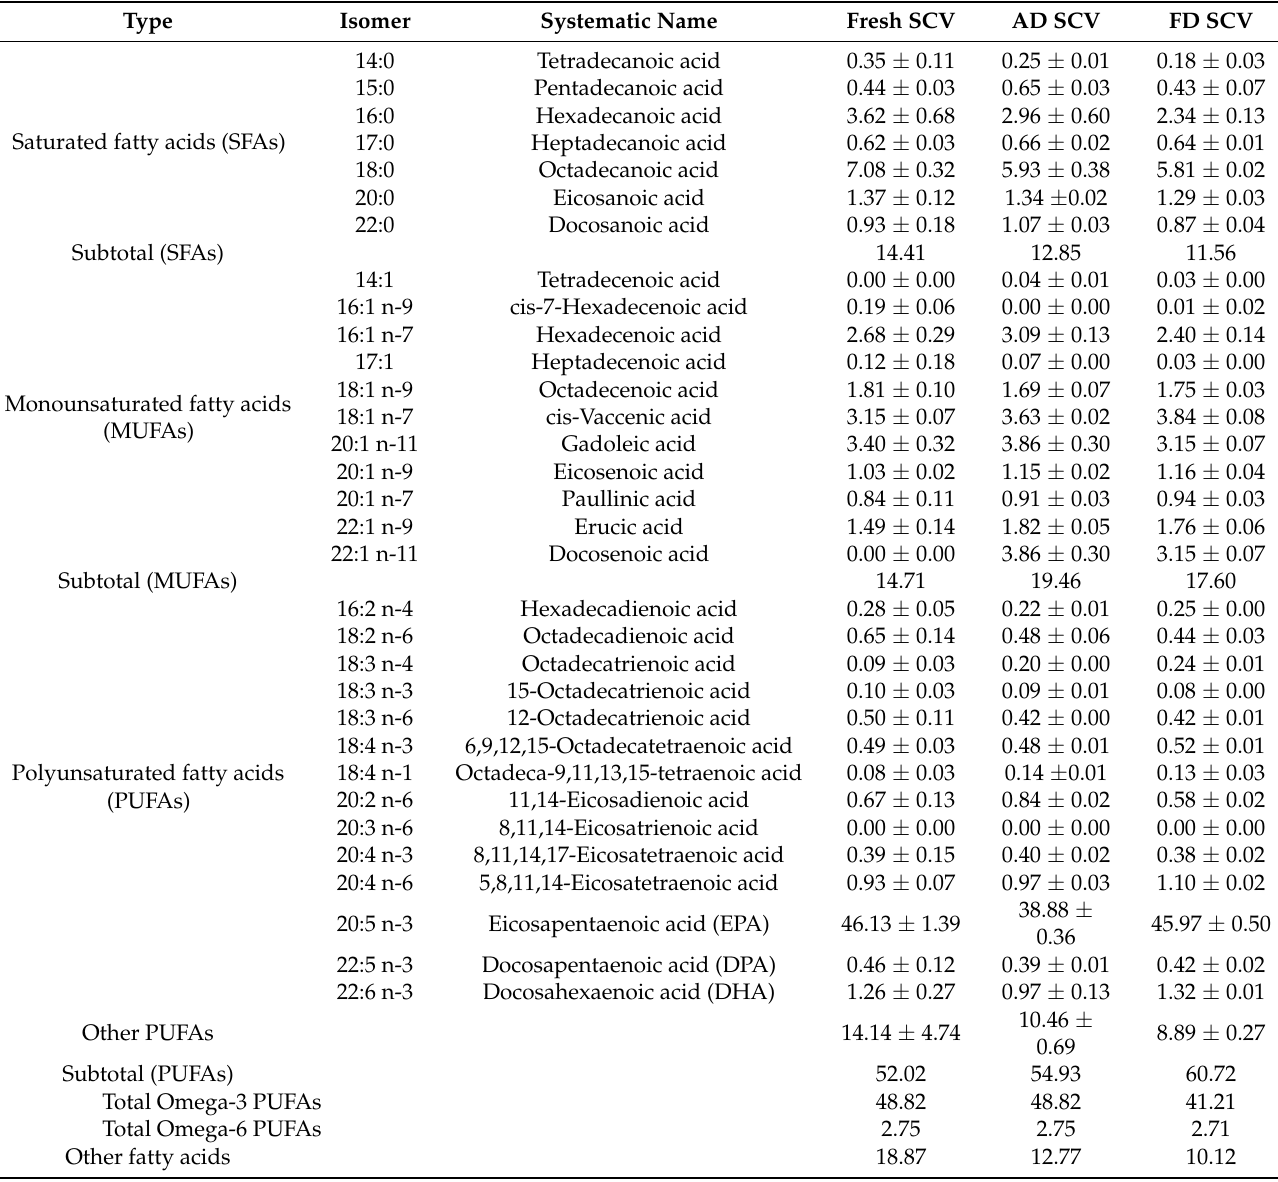
Table 5. Phospholipid fatty acid composition of fresh, air-dried (AD SCV), and freeze-dried (FD SCV) sea cucumber viscera.